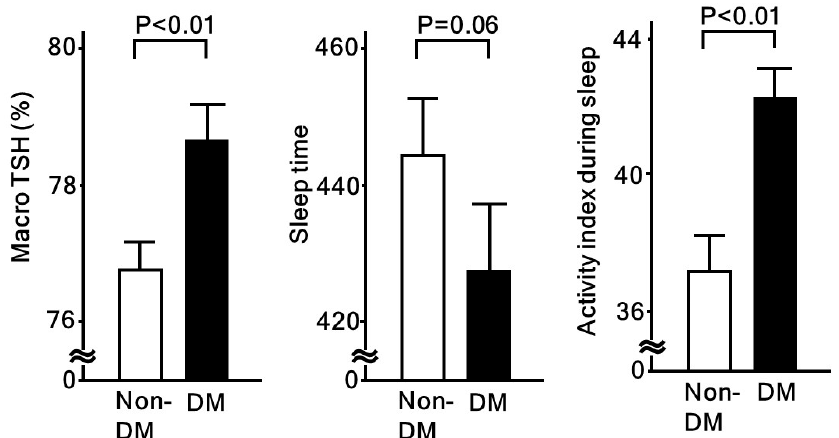
Figure 2. Macro-TSH and sleep quality assessed by actinography in patients with and without diabetes. Macro-TSH is significantly associated with low sleep quality [34]. When compared between non-diabetic (non-DM) and diabetic (DM) patients, all macro-TSH and activity index during sleep (high values represent poor sleep quality) were significantly higher in DM patients. Values shown in each column represent the mean ± standard error. Student’s t -test was used for analyses.